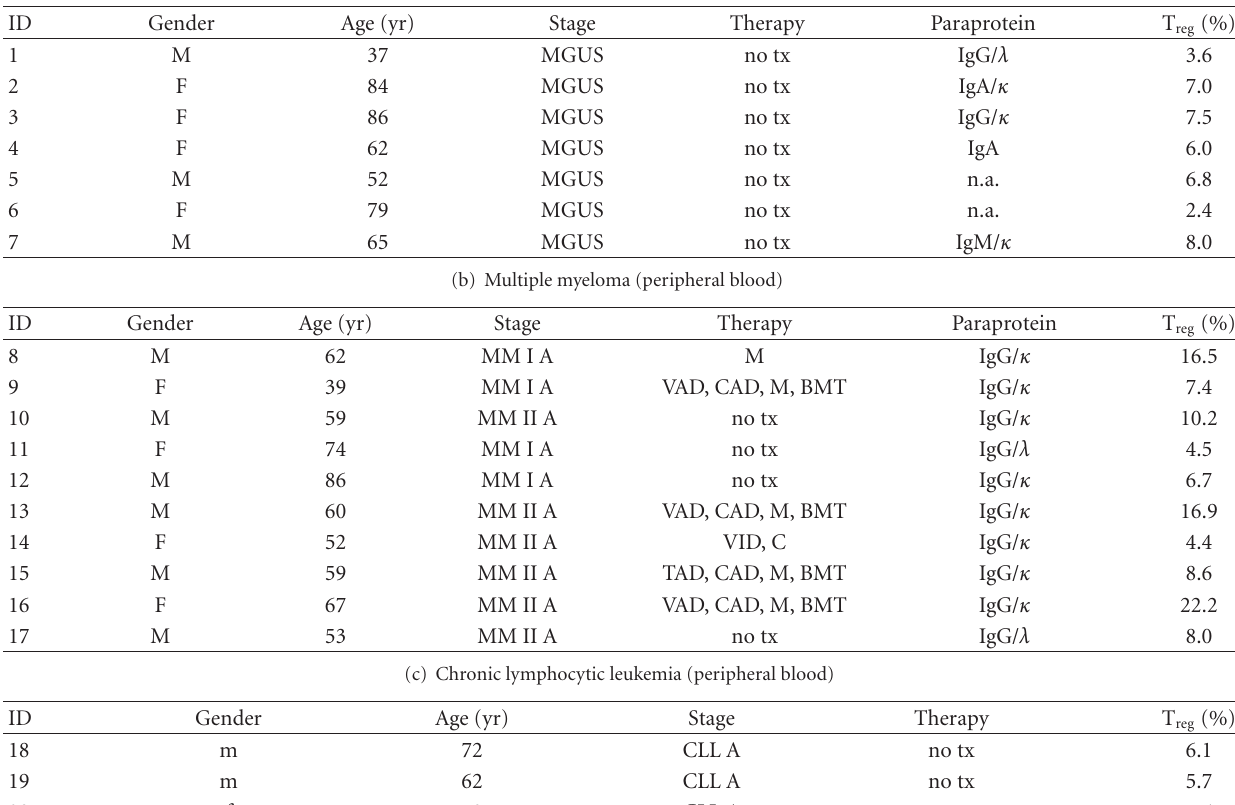
Table 1: Patient characteristics for T reg -cell assessment in peripheral